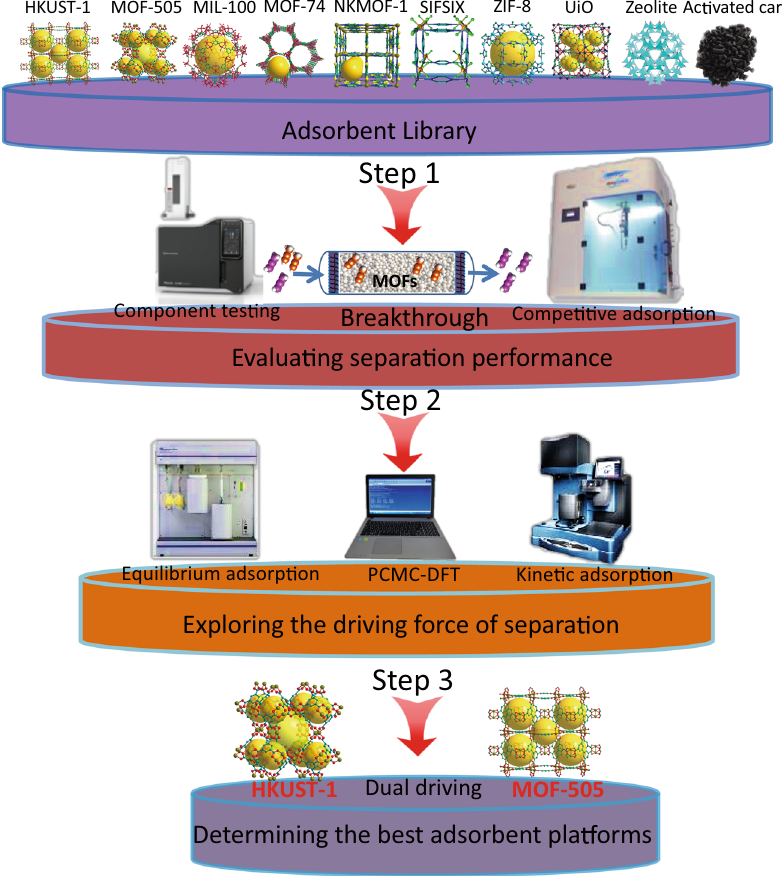
Fig. 3 Illustration of the assay package used herein for determining propyne/propadiene separation